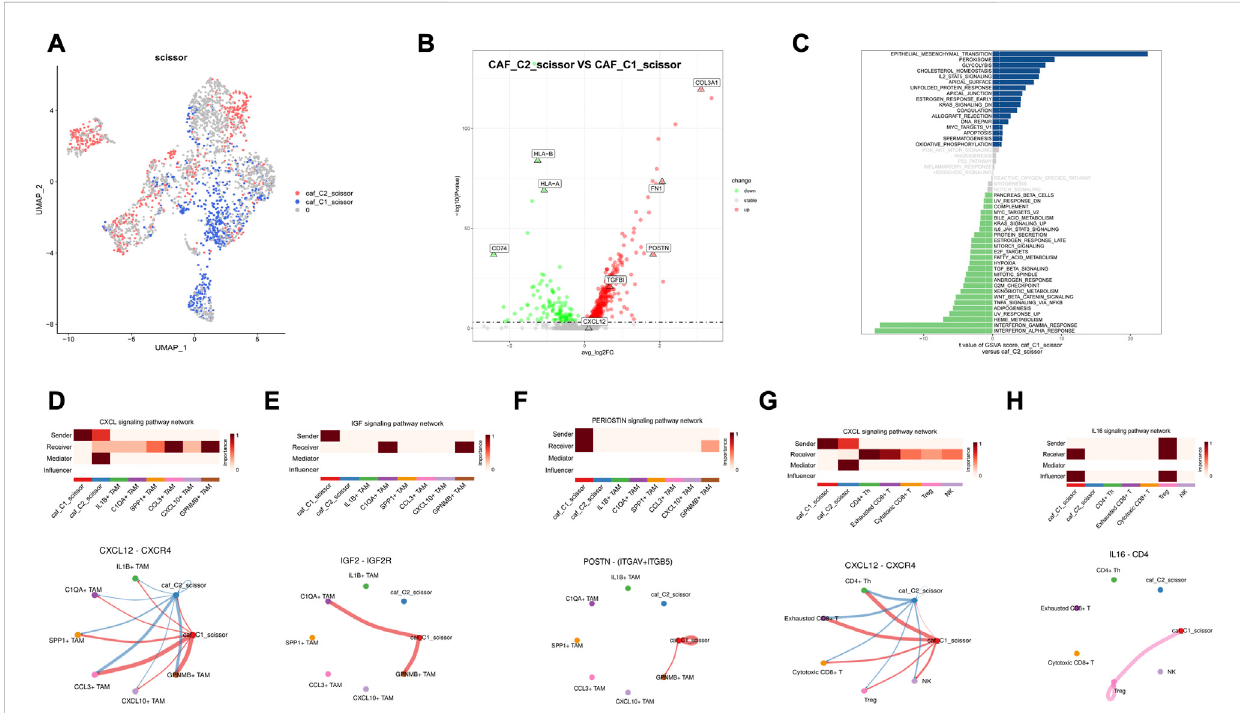
FIGURE 10 ResultsofScissoridenti fi cationinCAFcells (A) VisualizationofUAMPinCAFcells,caf_C1_scissorforScissorcellsrelatedtoC1subtype,andcaf_C2_ scissor for Scissor cells related to C2 subtype. (B) Volcano plot ofdifferential expression ofcaf_C1_scissor and caf_C2_scissor. (C) Map of GSVA pathway in CAF-related Scissor cells. (D,G) caf_C1_scissor interacts signi fi cantly with TAM and T-cells via CXCL12_CXCR4. (E) caf_C1_scissor1 interacts signi fi cantly with C1QA + TAM via IGF signaling pathway. (F) caf_C1_scissor interacts signi fi cantly with TAM cells through the POSTN signaling pathway. (H) caf_C1_scissor interacts signi fi cantly with Treg cells via IL16 signaling